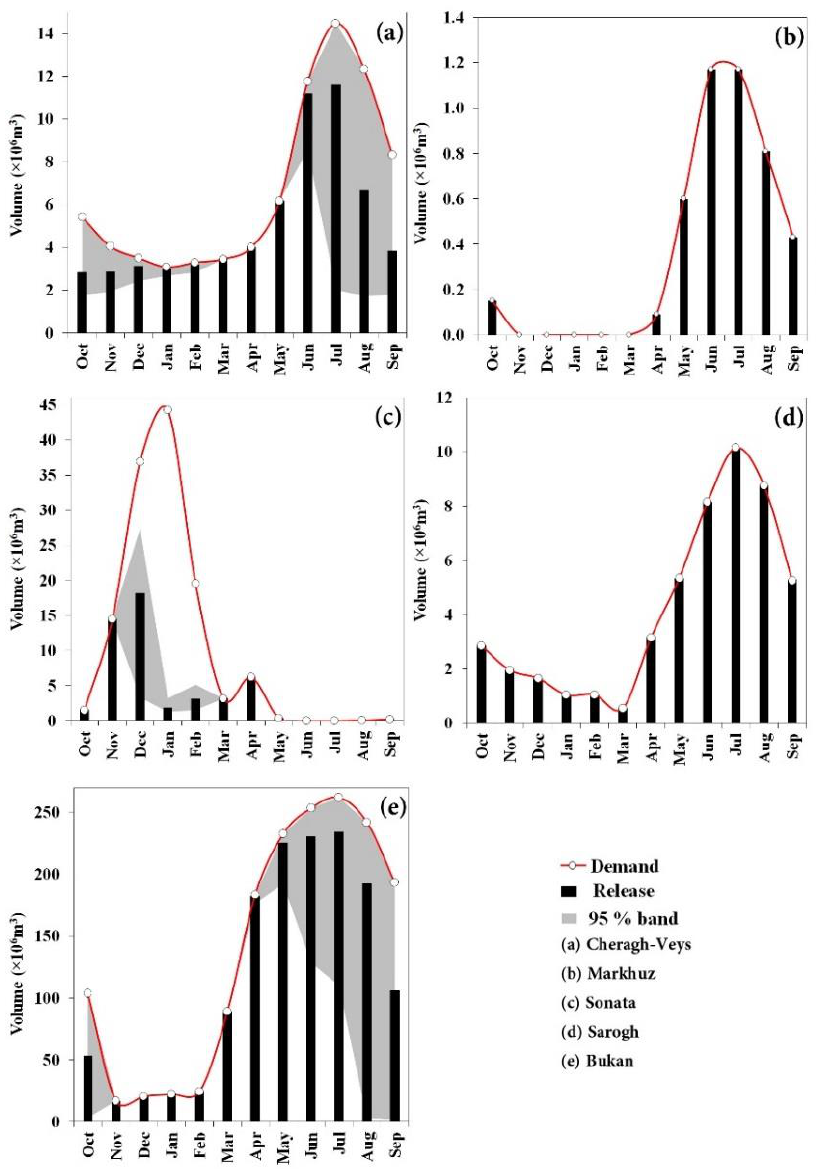
Figure 9. The results of monthly average simulation of the Zarrineh-Rud river basin.